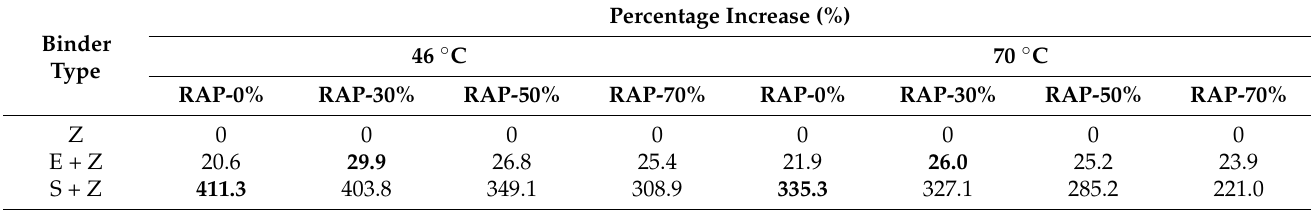
Table 8 indicates that the inclusion of S could increase | G *|/sin δ by up to 411.3% and 335.3%, but the use of E could only increase | G *|/sin δ by up to 29.9% and 26.0%, respectively, at the temperatures of 46 ◦ C and 70 ◦ C under the short-term aged condition. Table 8. Percentage increase in | G *|/sin δ caused by the WMA additive under the short-term aged